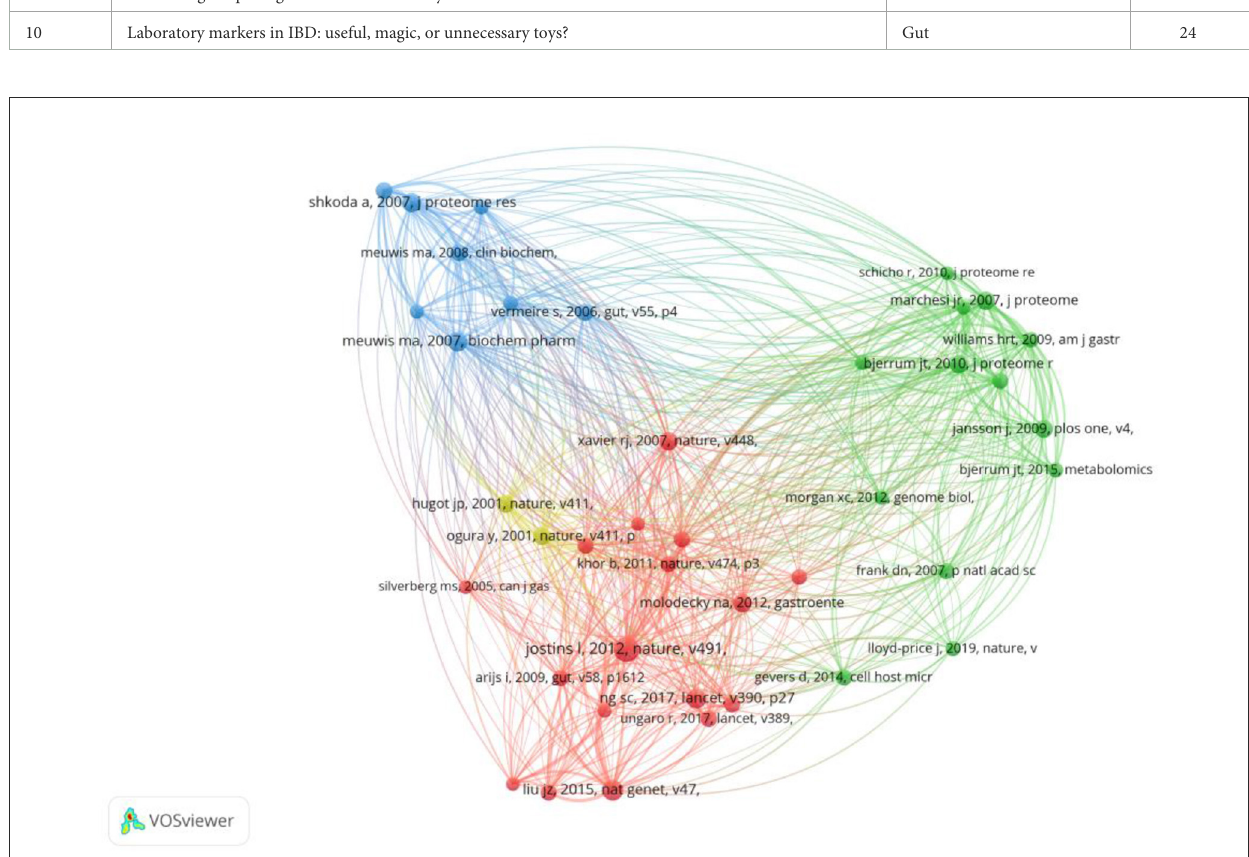
FIGURE6 Network of co-cited references on research of omics in UC.